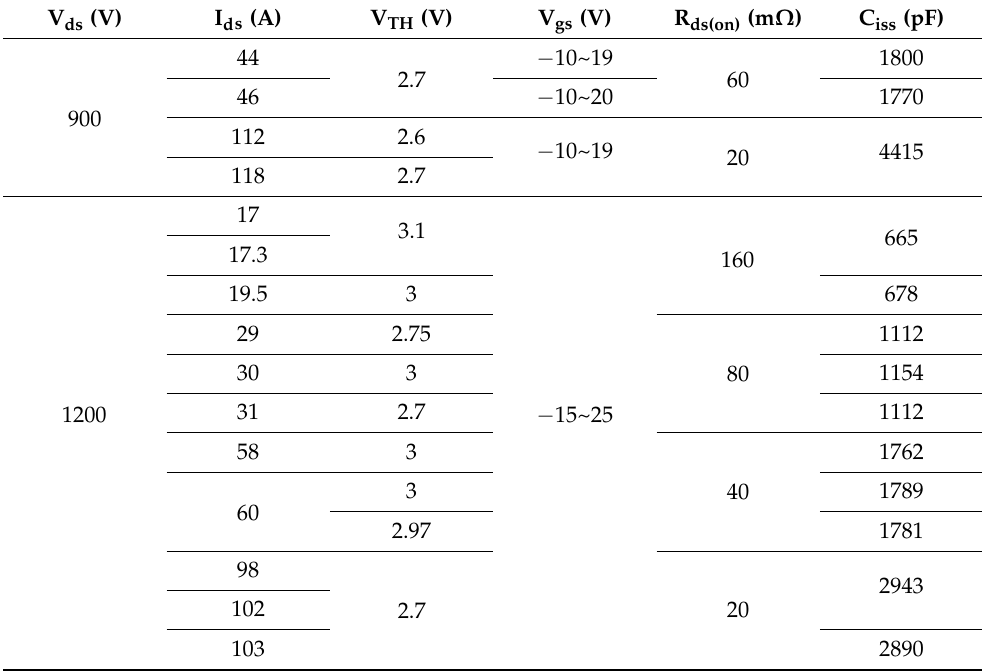
Table 4. Commercial 600~1200 V SiC MOSFETs by On Semiconductor.